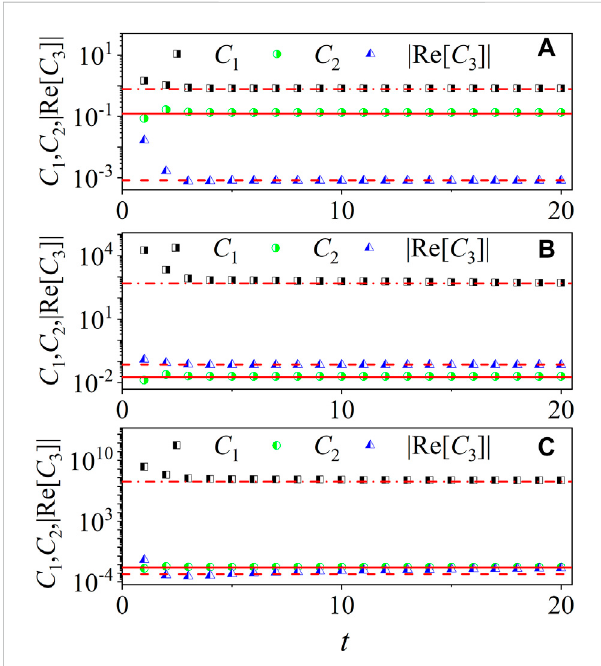
FIGURE 5 C | Re [ C ]| (triangles) versus time with C 3 1 (squares), 2 (circles), and B = p (A) , p 2 (B) , and p 3 (C) . Dash-dotted, solid, and dashed lines indicateourtheoreticalpredictioninEq.11for C 1 ,Eq.13for C 2 ,andEq. 15 for C 3 , respectively. The parameters are the same as in Figure 2.